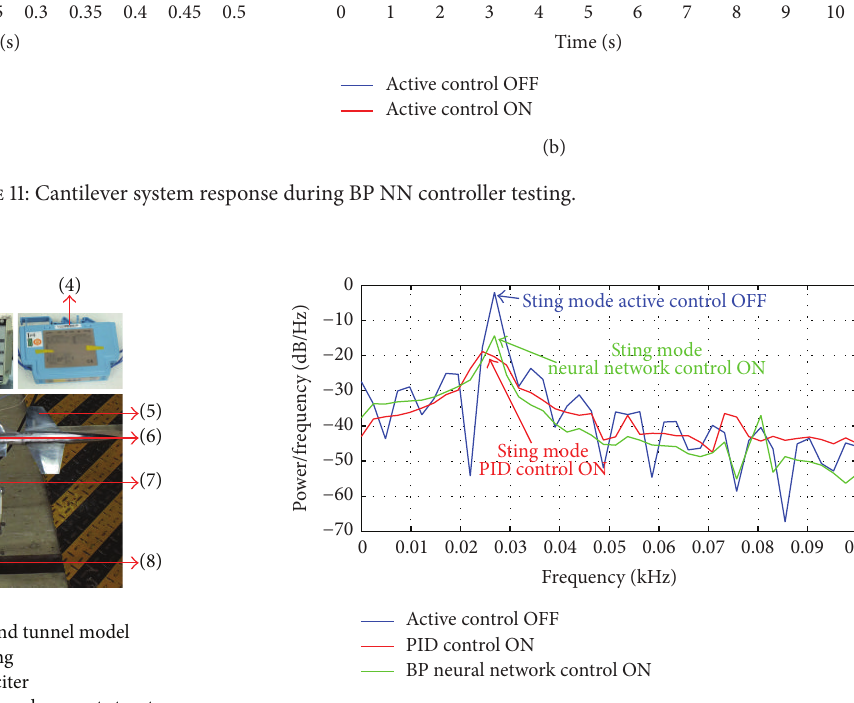
Figure14:Attenuationofstingmodebystingdamperduringexciter stimulation